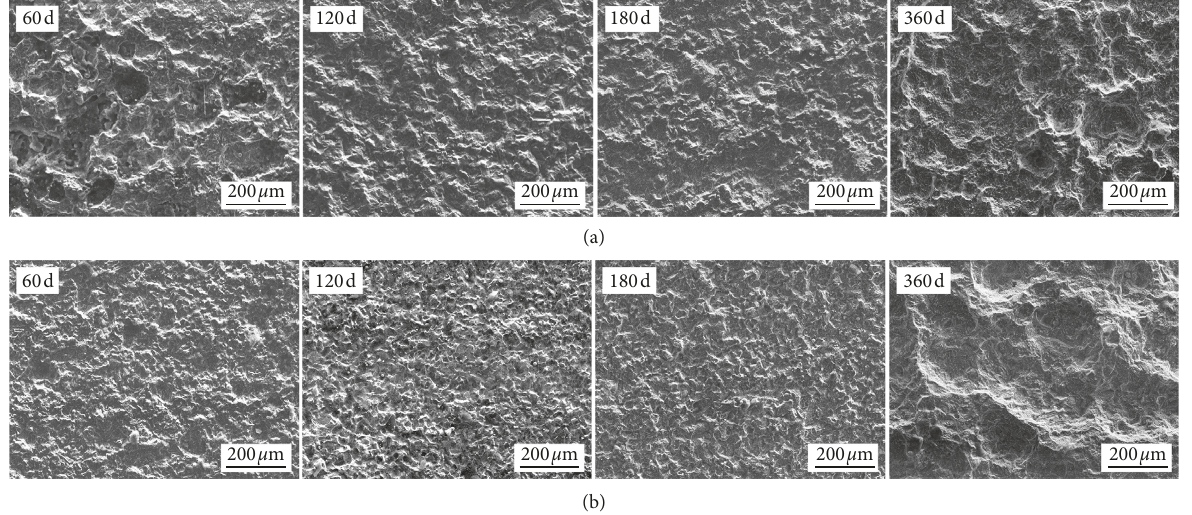
Figure 4: Evolution of corrosion morphology on HAZ’s surface. (a) HAZ processed by VSR. (b) HAZ unprocessed by